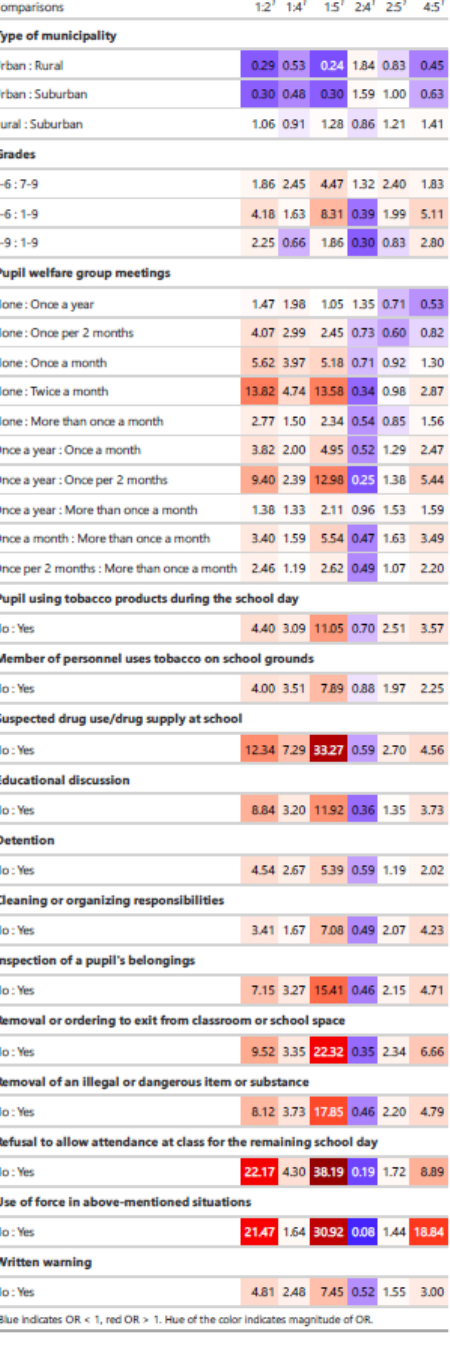
Figure 1. Heatmap indicating odds ratios for the pairwise